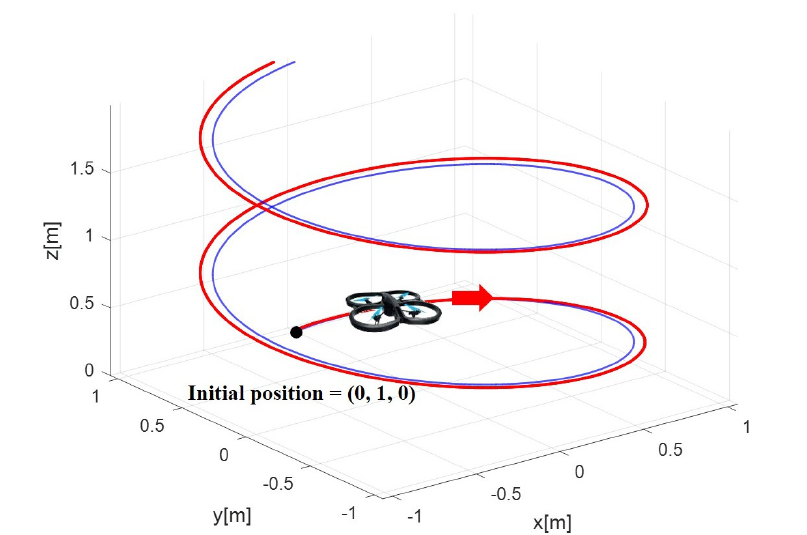
Figure 8. The trajectory tracking control of a quadrotor. The dashed blue line indicates the reference trajectory and the solid red line is the result of the simulation.